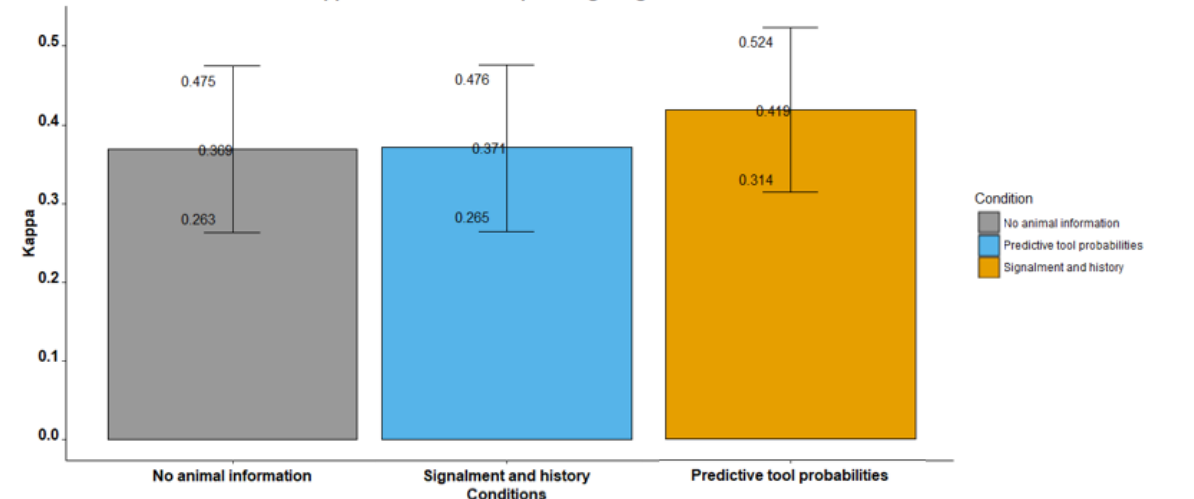
Figure 3. Bar plot showing the inter-pathologist agreement kappa statistics with 95% CI for the three slide-reading conditions, diagnosing glass slides of canine and feline bladder tissue.